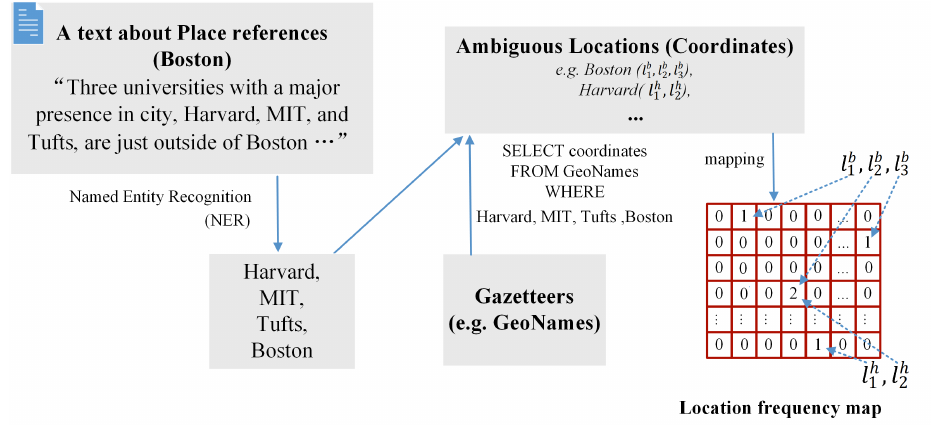
Figure 1. The generation of location frequency